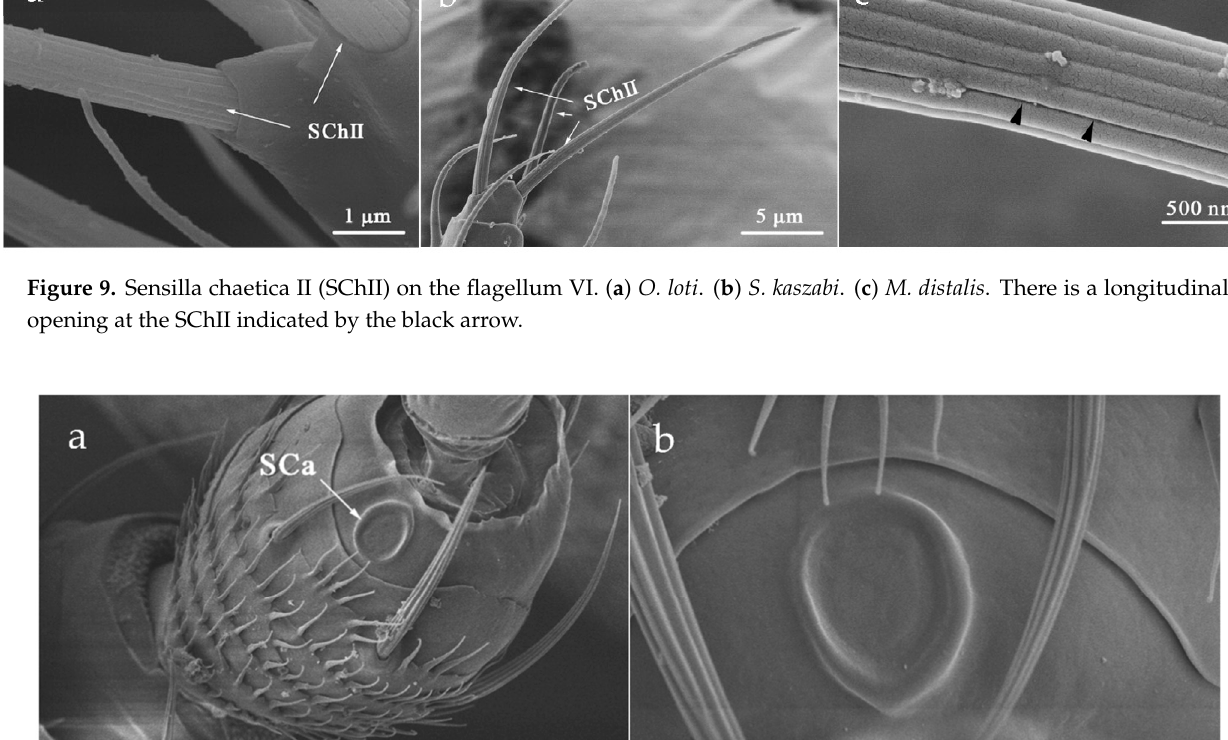
Figure 9. Sensilla chaetica II (SChII) on the flagellum VI. ( a ) O. loti . ( b ) S. kaszabi . ( c ) M. distalis . There is a longitudinal opening at the SChII indicated by the black arrow.